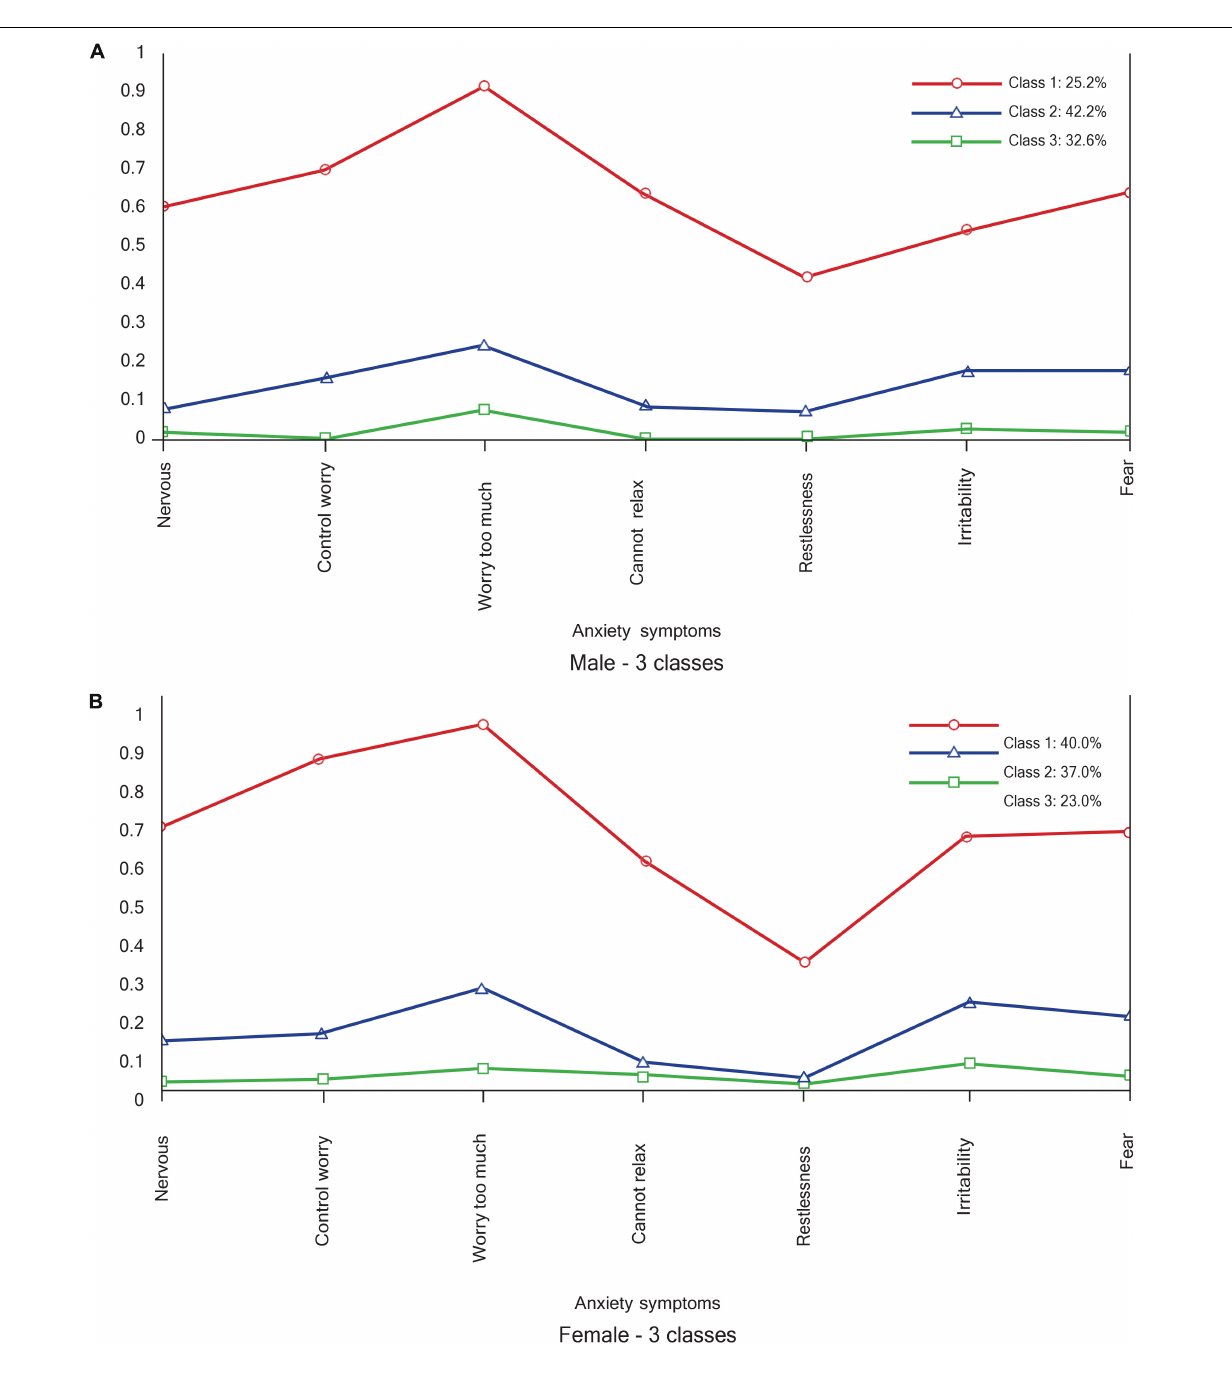
FIGURE 4 | Anxiety profiles. (A) Male – 3 classes. (B) Female – 3